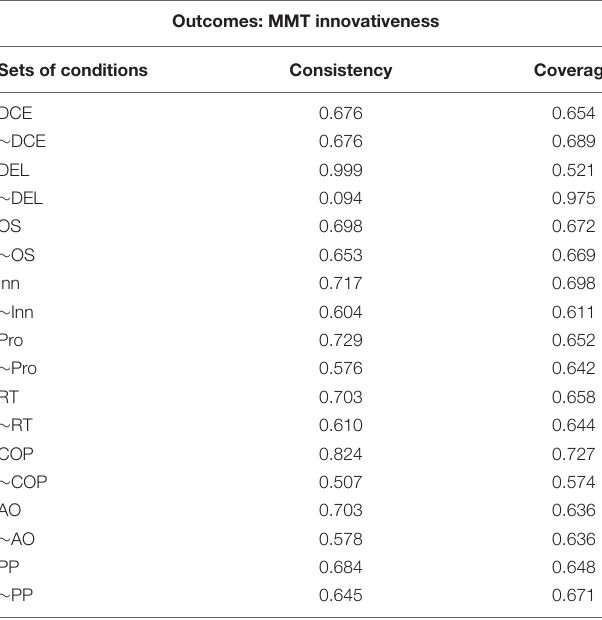
TABLE 2 | Analysis of necessary conditions for middle management team innovativeness in fuzzy-set qualitative comparative analysis. Outcomes: MMT innovativeness